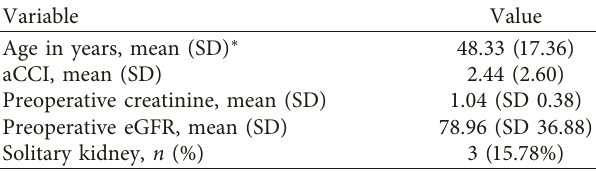
Table 5: OKT outcomes.